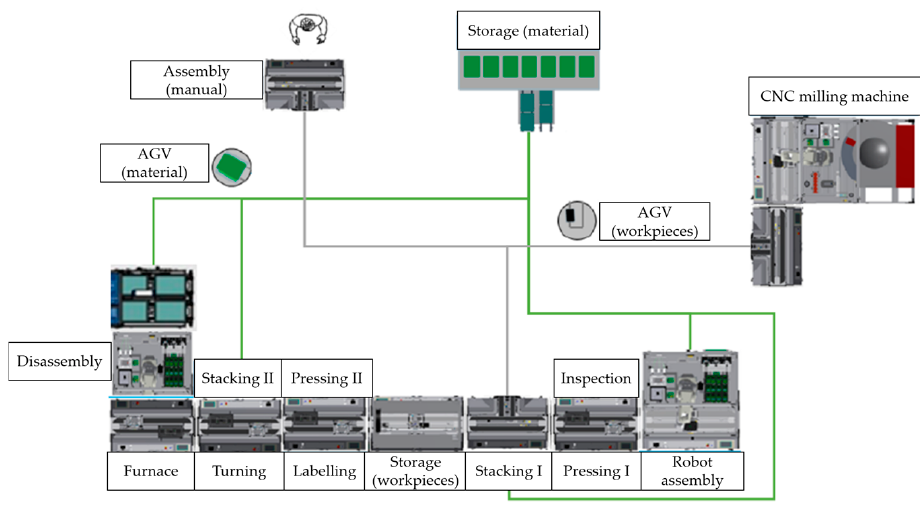
Figure 9. Structure and processes in the IIoT TB.